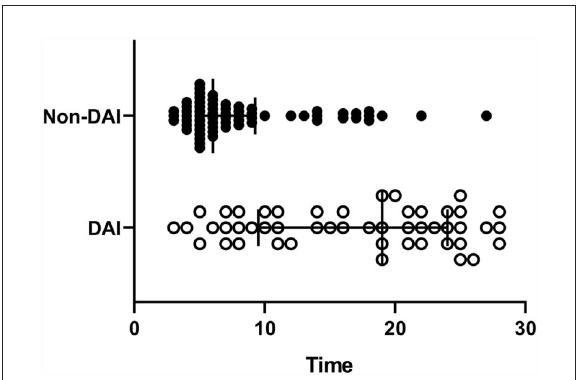
FIGURE1 The timing of the MRI scans post-injury. The diffuse axonal injury (DAI) group was significantly longer than the non-DAI group ( p < 0.0001), 19 (10–24) vs. 6 (5–9), and median [interquartile range